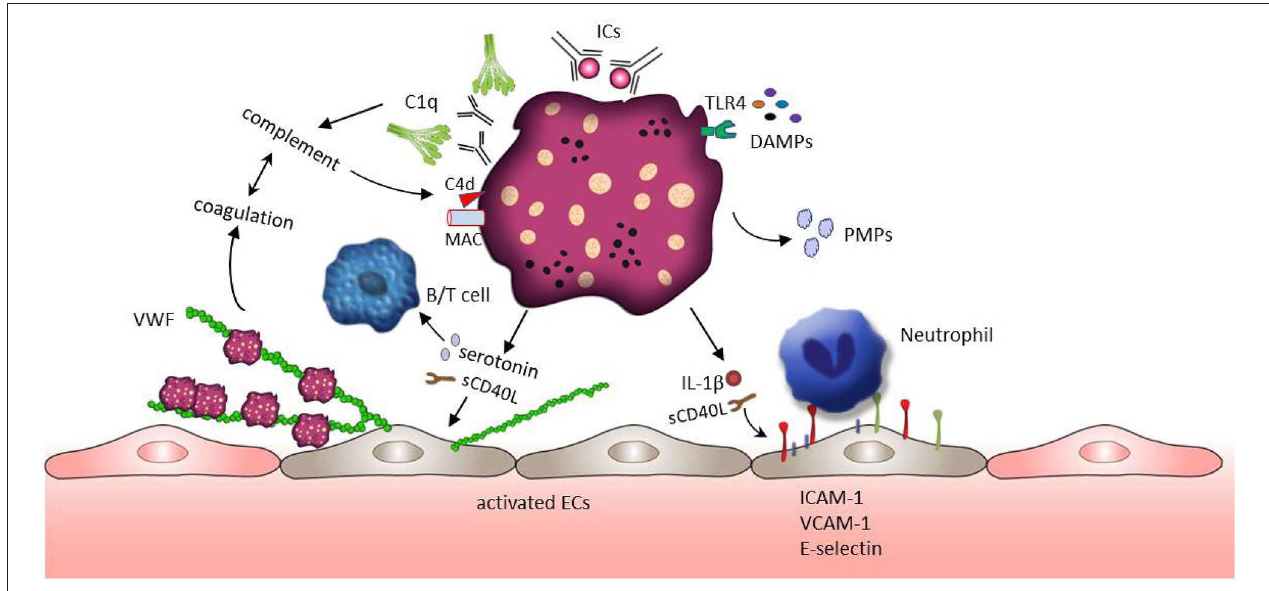
FIGURE 2 | Platelet activation and subsequent effects in SLE. ICs and DAMPs (e.g., HMGB1 or S100A8/9), both enriched in the blood of SLE patients, activate platelets through binding to platelet surface receptors Fc γ RIIA and TLRs. ICs further induce the complement system activation leading to the deposition of complement fragments (e.g., C1q,C4d, MAC) on the platelet surface which in turn further potentiates platelet activation. Activated platelets release their contents such as IL-1 β , sCD40L, and serotonin. These factors mediate the up-regulation of adhesion molecules (e.g., E-selectin, VCAM-1, and ICAM-1) on endothelial cells, promoting the adhesion of immune cells. In addition, sCD40L and serotonin can stimulate the release of VWF from endothelial cells, but also support B cell and T cell activation. VWF mediated trapping and activation of platelets initiate coagulation which may further foster the activity of the complement system building a positive feedback